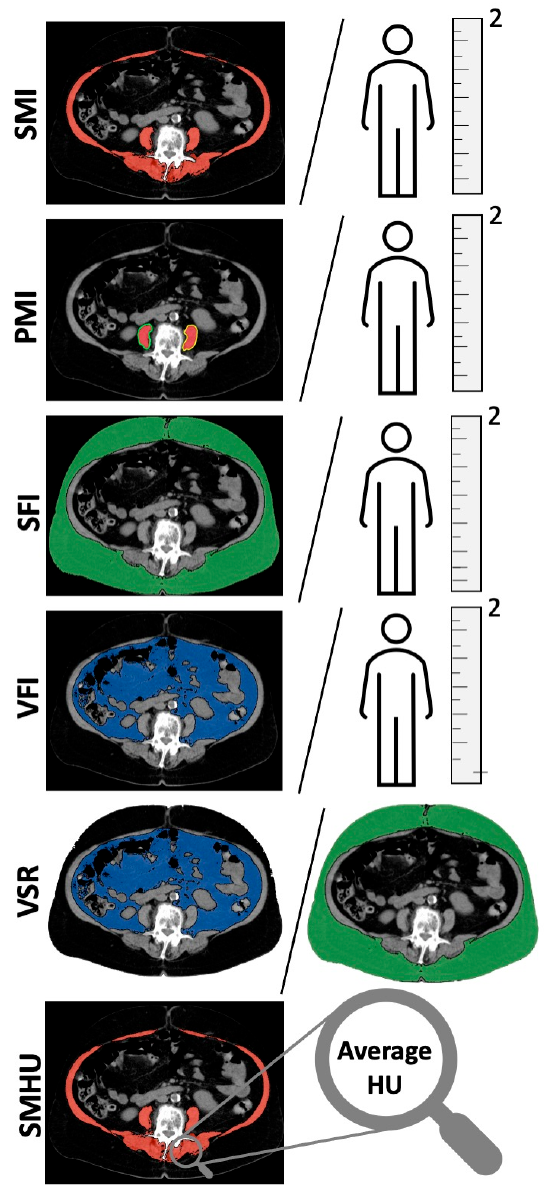
Figure 2. Illustration of different body composition measurements at the height of lumbar vertebra 3. From top to bottom, skeletal muscle index (SMI), psoas muscle index (PMI), subcutaneous fat index (SFI), visceral fat index (VFI), visceral-to-subcutaneous fat ratio (VSR) and skeletal muscle Hounsfield units (SMHU) are shown.